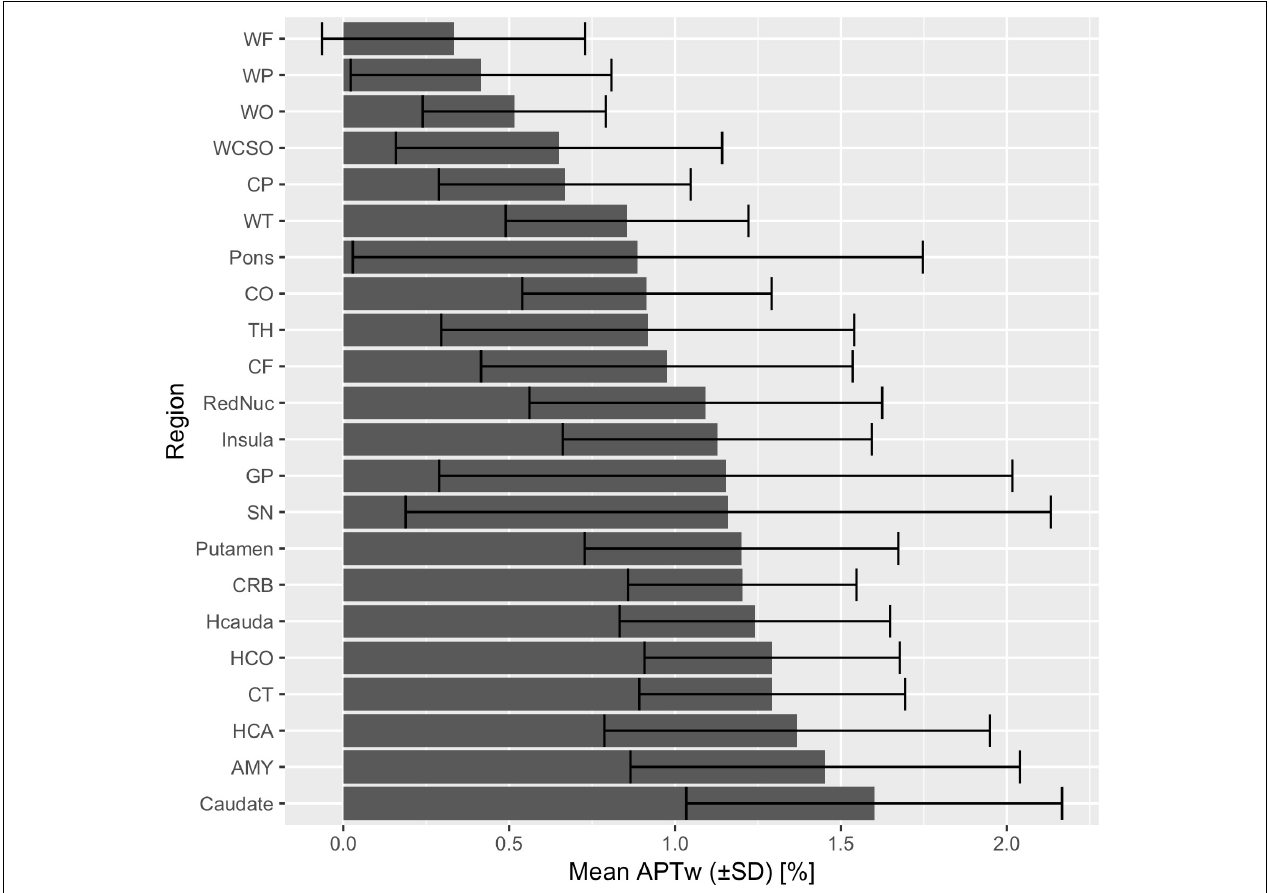
FIGURE 3 | Mean APTw intensity values (bihemispheric) with standard deviations are shown for each brain region in ascending